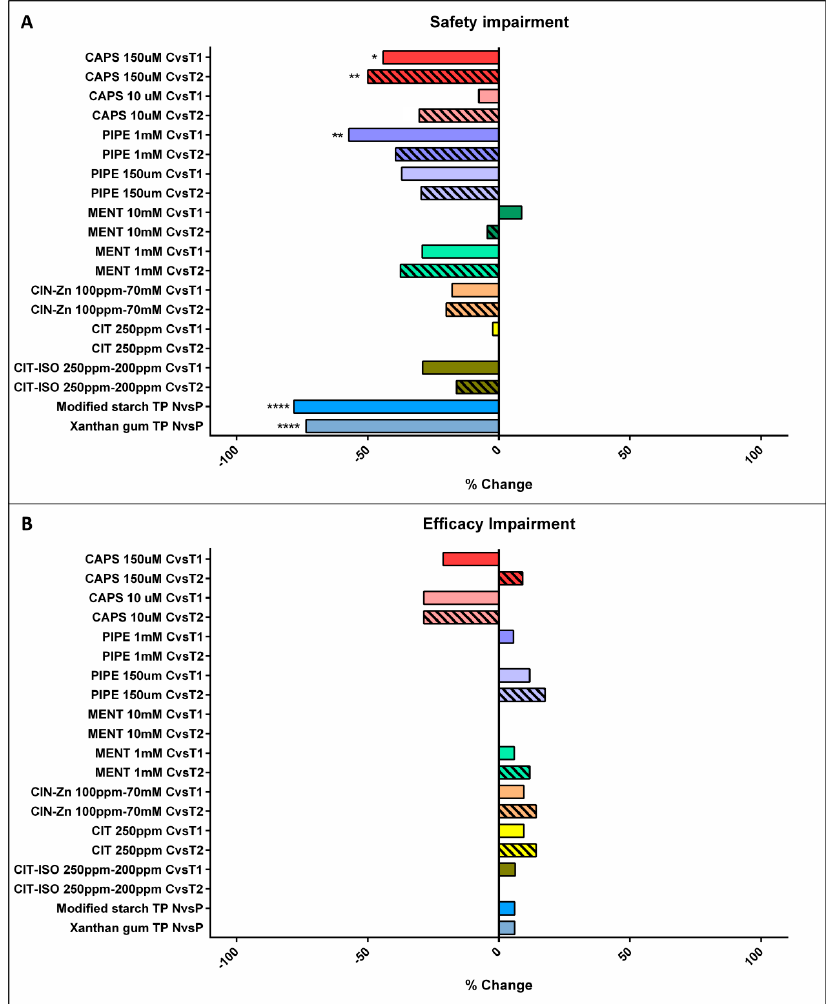
Figure 1. Normalized effect of compensatory and active treatments on signs of safety ( A ) and efficacy ( B ). CAPS: capsaicin; PIPE: piperine; MENT: menthol; CIN-Zn: cinnamaldehyde-zinc; CIT: citral; CIT-ISO: citral-isopulegol; C: control nectar; T1: supplemented nectar 1; T2: supplemented nectar 2; N: nectar; P: pudding; TP: thickening product; *: p < 0.05; **: p < 0.01; ****: p < 0.0001.